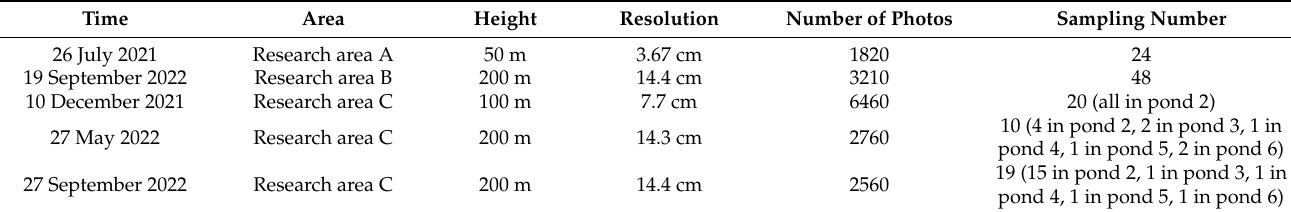
Table 3. Flight and sampling